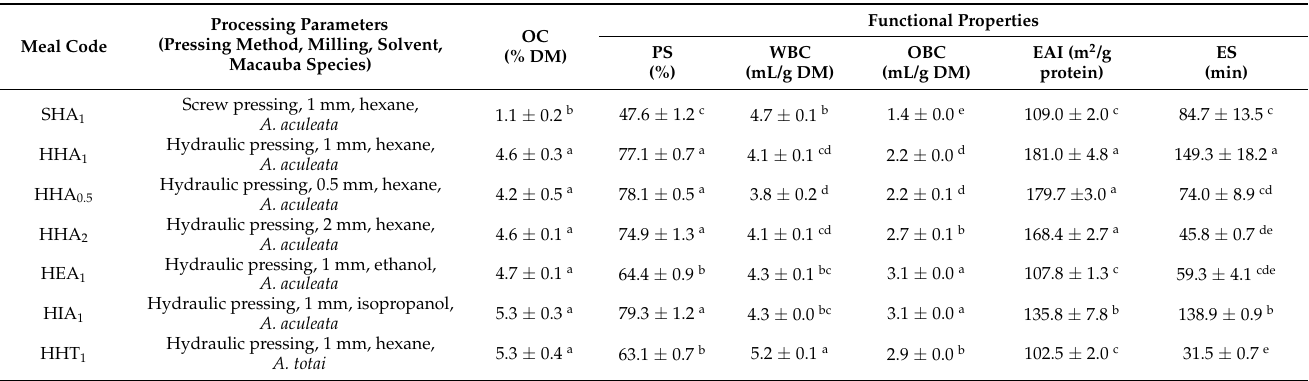
Table 2. Influence of oil extraction conditions on the oil content and functional properties of macauba kernel